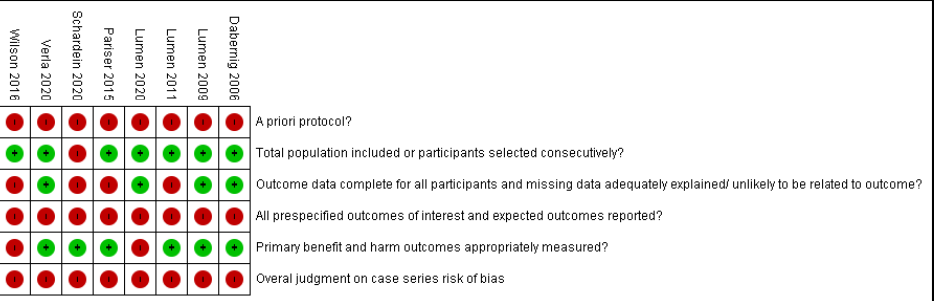
Figure 3. Risk of bias assessment per included study, using the 5-criterion quality appraisal checklist. Green: Low risk of bias, Red: High risk of bias.